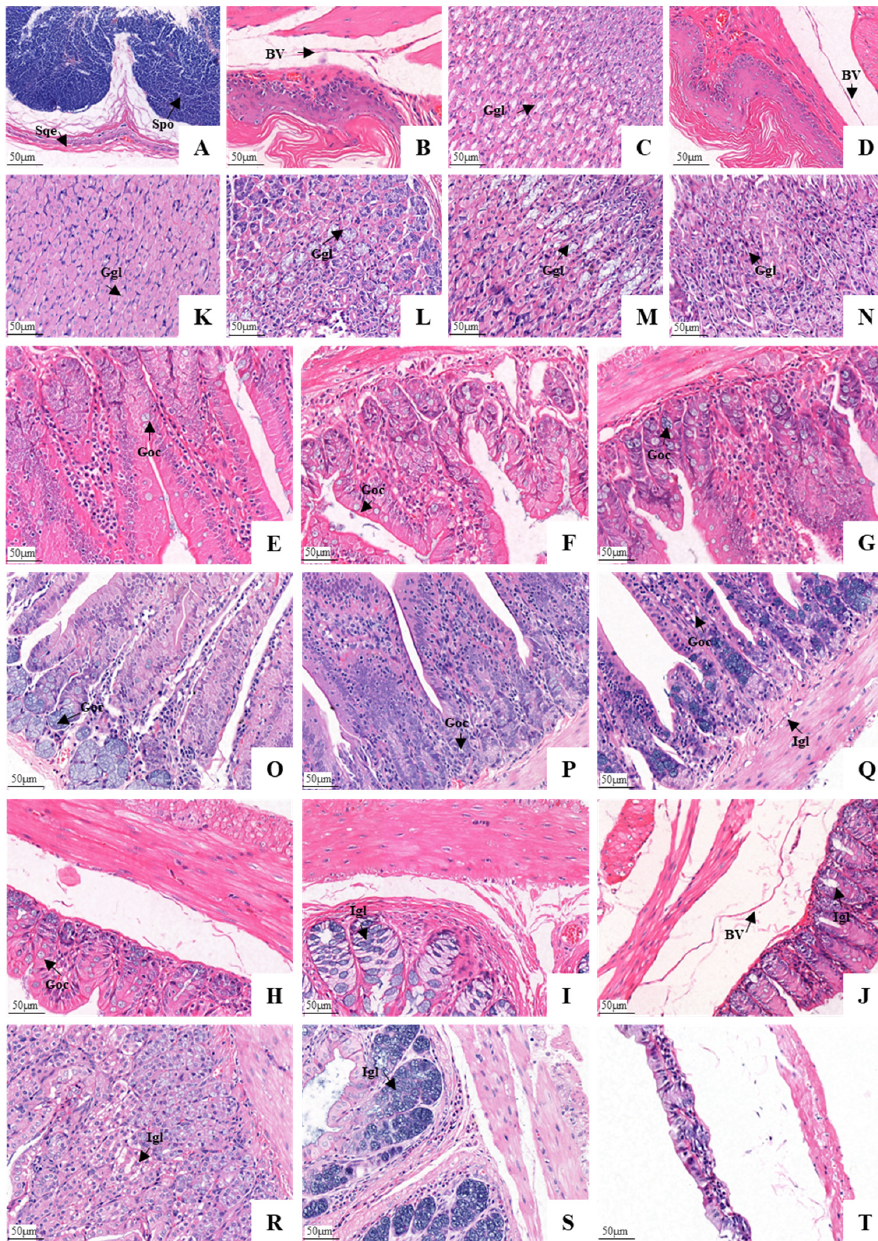
Figure 7. Histological comparison between the plateau zokor’s and the plateau pika’s gastrointestinal organs (400× magnification). ( A – J ) Stomach, (( A – D ) fundus, corpus I, corpus II, and pylorus of stomach), duodenum, jejunum, ileum, colon, rectum, and cecum of the plateau zokor, respectively; ( K – T ) gastrointestinal organs of the plateau pika, in the same order as above. BV: blood vessels; Goc: goblet cells; Ggl: gastric glands; Igl: intestine glands; Spo: spongy structure; Sqe: squamous